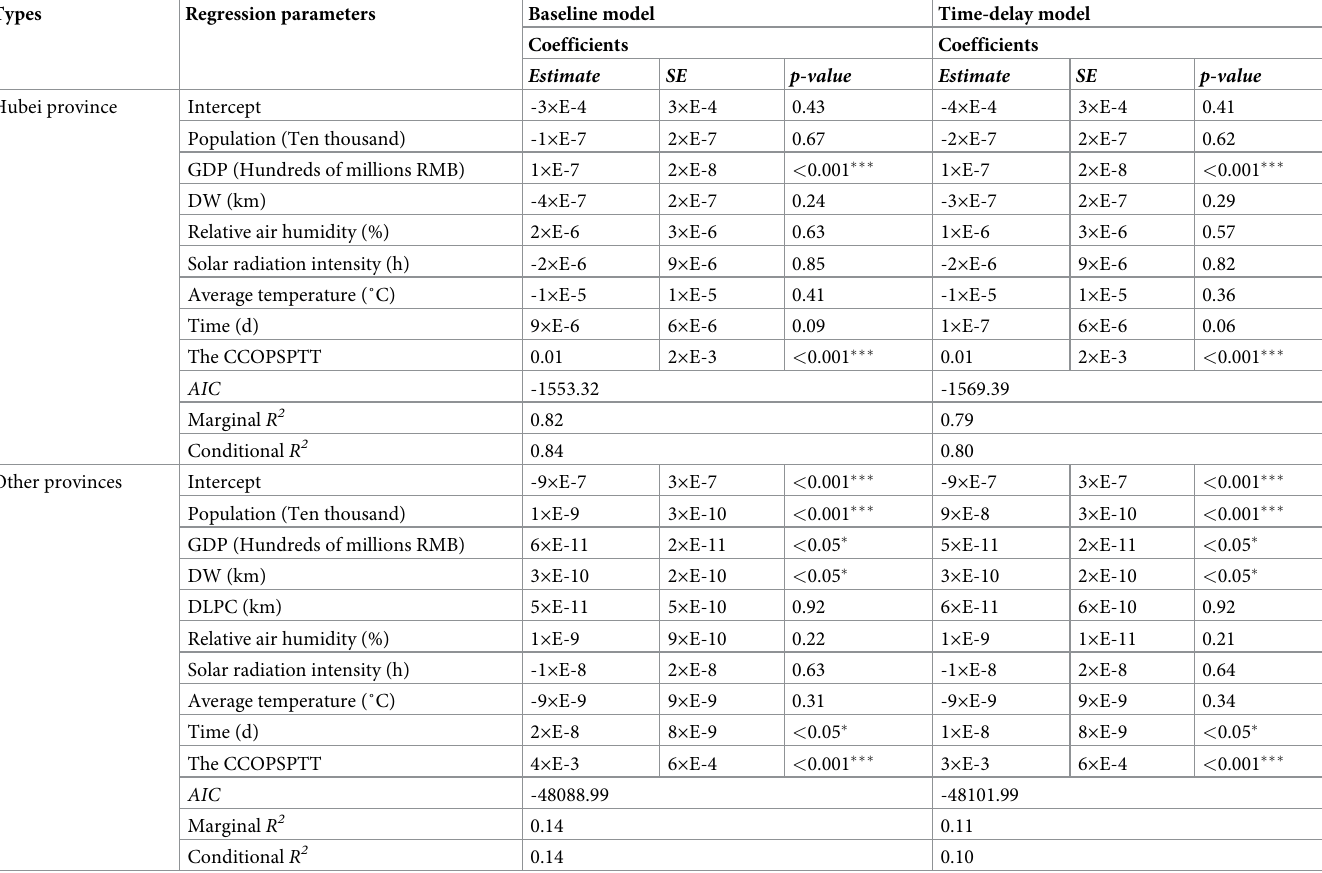
Table 5. Results of GLMs in relationship of deaths over population size per 100000 at every 5 consecutive days (DOPSPTT) with the CCOPSPTT, socio-economic determinants, spatial distance, climate factors and time in cities outside and within Hubei province.